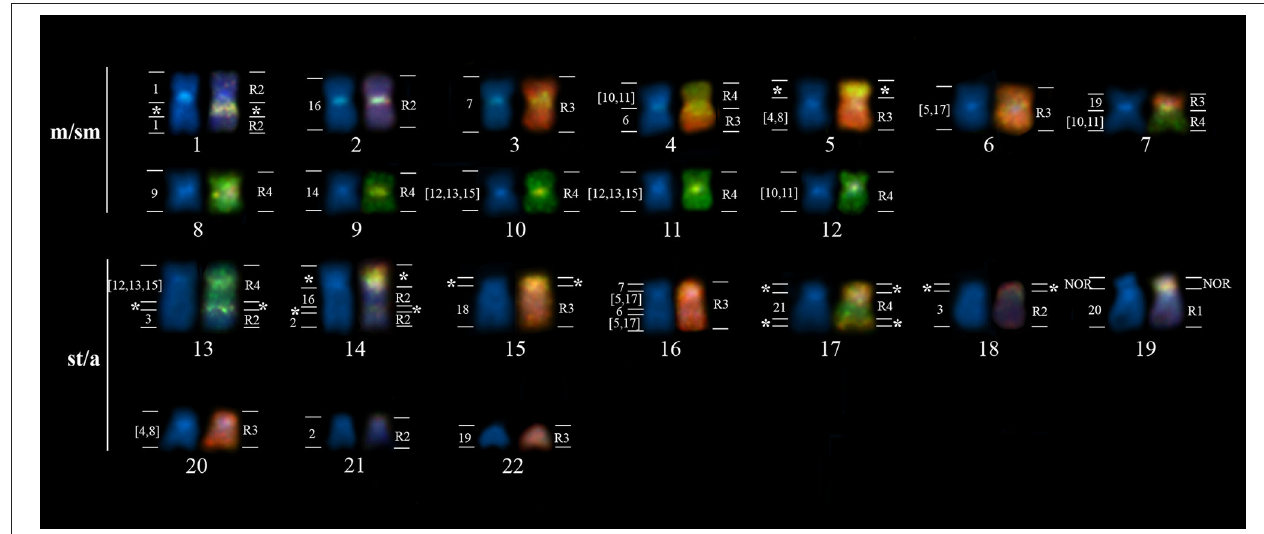
FIGURE 3 | Haploid karyotype of G. arapaima (GAR) arranged from mitotic chromosomes after dual-color hybridization with probes derived from Region 3 (R3, red) and Region 4 (R4, green) from the Gymnotus carapo (GCA) chromosome complement. Regions R1 and R2 were not subjected to FISH analysis and, therefore, the equivalent homeologous parts on GAR chromosomes are DAPI-stained (blue) only. For each of the 22 GAR chromosome pairs, the DAPI-only stained homolog is depicted on the left, while the dual-color FISH hybridization pattern is present on the right. The correspondence to G. carapo (GCA) homeologous chromosomes is indicated by chromosome pair numbers on the left side of the DAPI-stained GAR chromosomes, while the correspondence to the particular GCA regions (R1–4) is indicated on the right side of FISH-painted chromosomes. *Repetitive sequences.